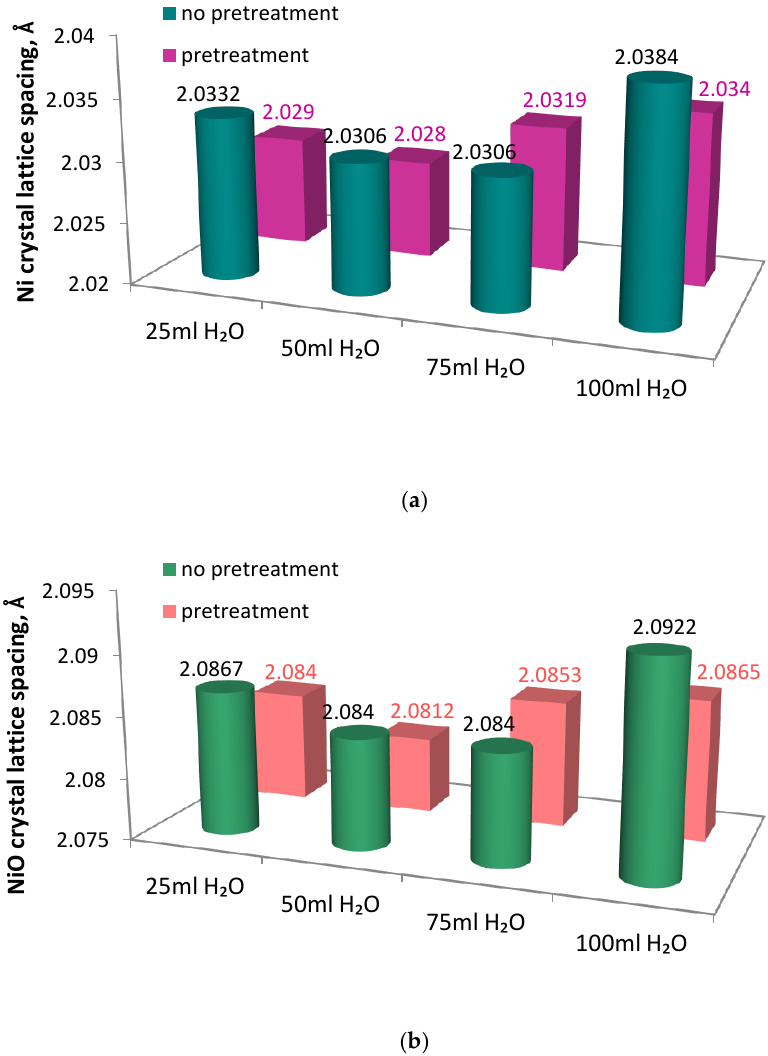
Figure 4. Influence of heated stirring on the crystal lattice spacing of ( a ) Ni and ( b ) NiO.